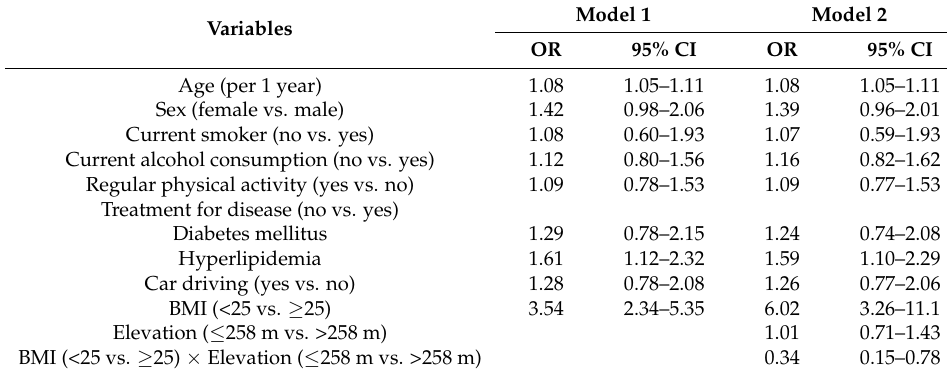
Table 3. Multivariable logistic regression analysis with hypertension (Definition 2) as the dependent